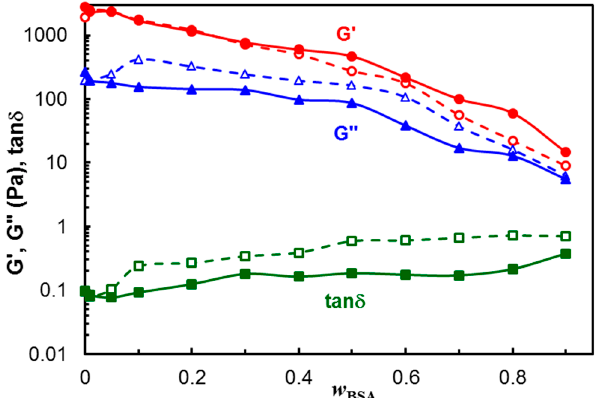
Figure 3. Viscoelastic parameters as a function of w BSA for PVA/HPC and hybrid polymer/BSA hydrogels after 3 freezing thawing cycles, ω = 1 rad/s, γ = 1%, at 25 °C (empty symbol, dashed line) and 37 °C (full symbol, continuous line). The lines are a guide to the eye.